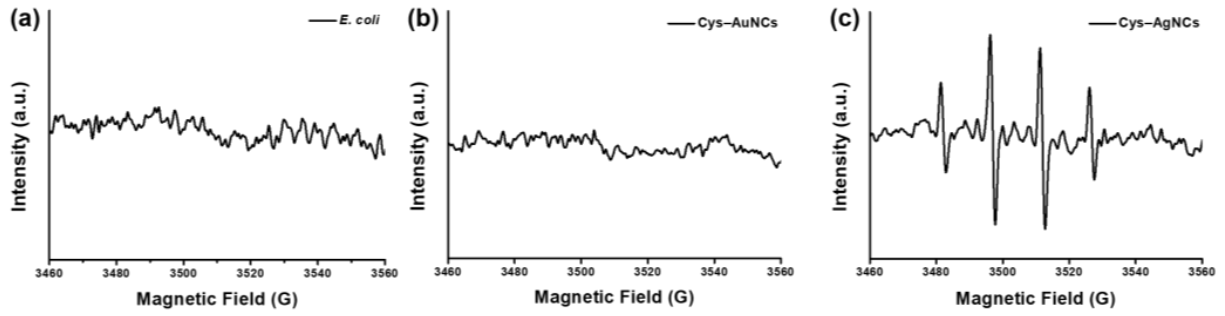
Figure 6. EPR spectra of the ( a ) E. coli solution, ( b ) Cys–AuNCs, and ( c ) Cys–AuNCs.